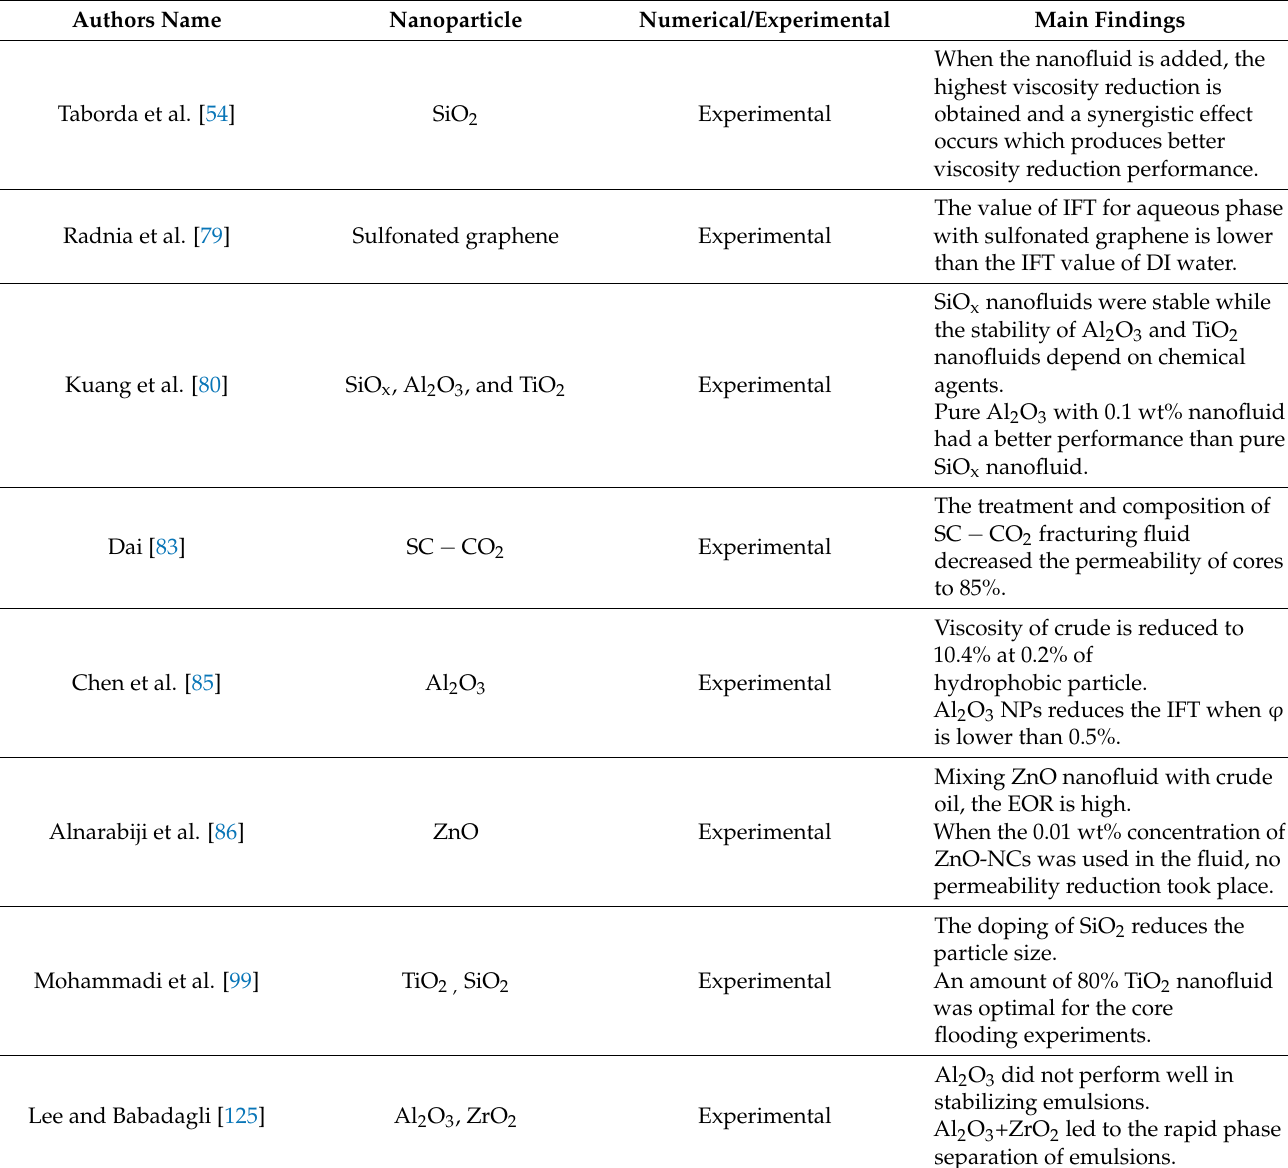
Table 7. Comparison of previous investigations on crude-oil-based